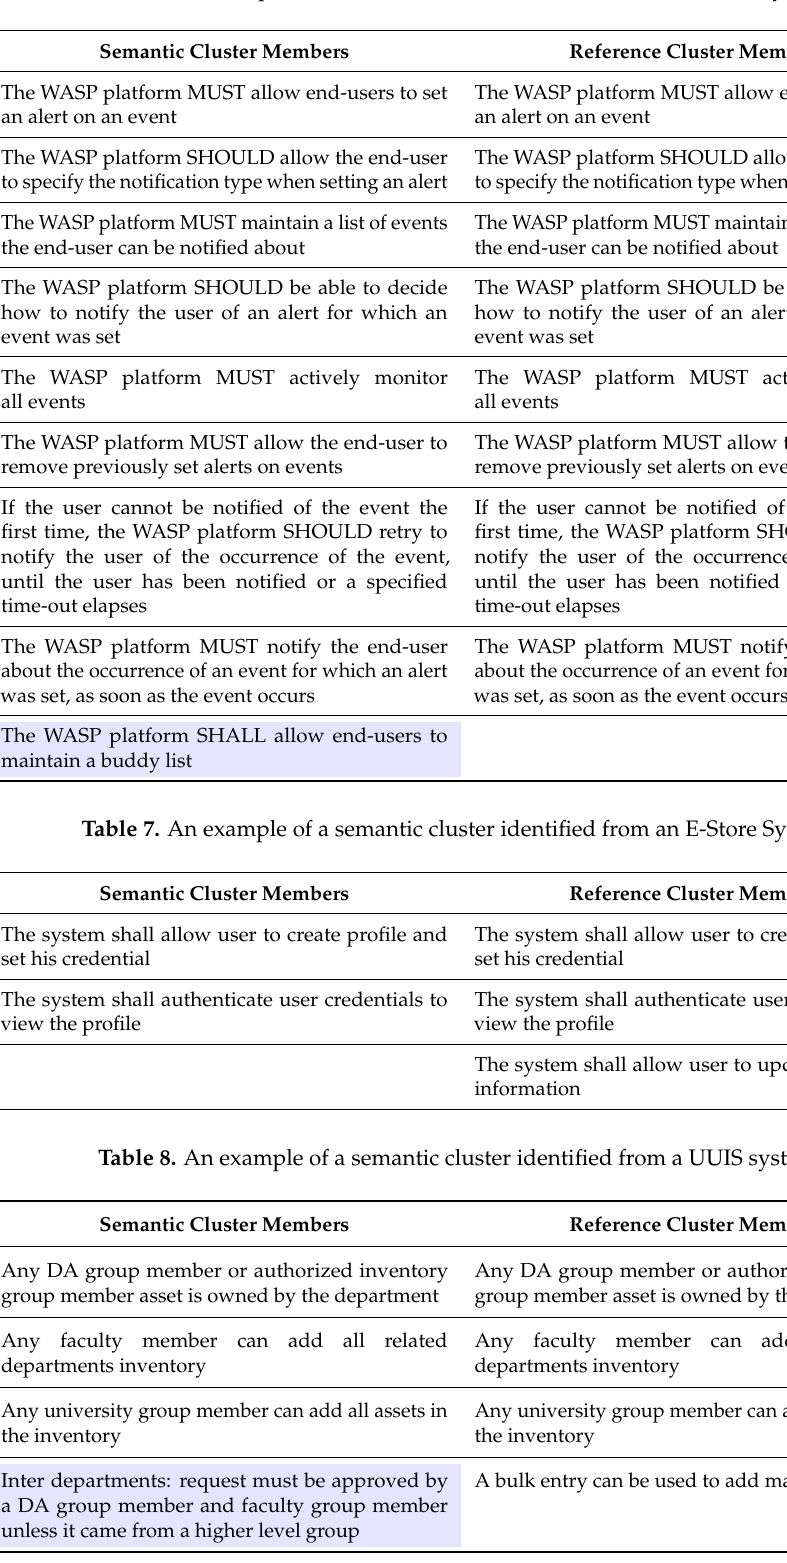
Table 6. An example of a semantic cluster identified from the WASP system.